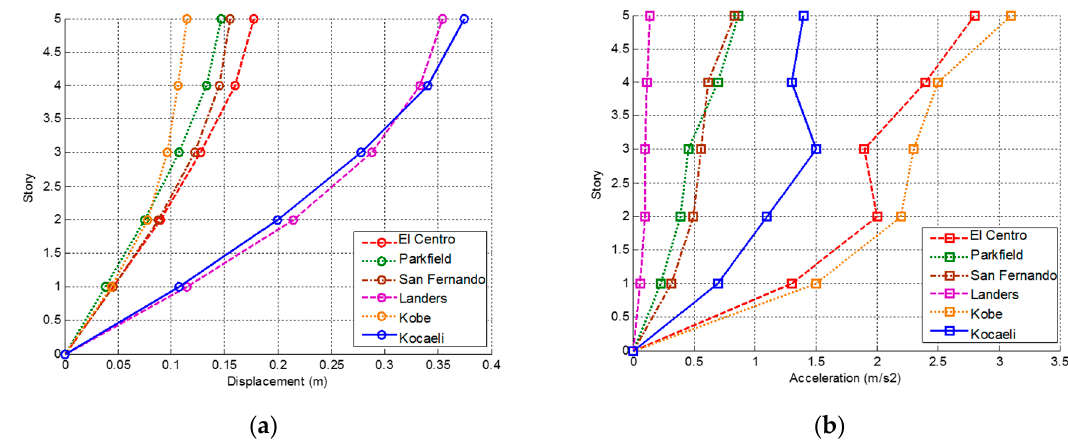
Figure 7. The results of ( a ) peak displacement and ( b ) peak acceleration for different stories of building after changing the story damping.